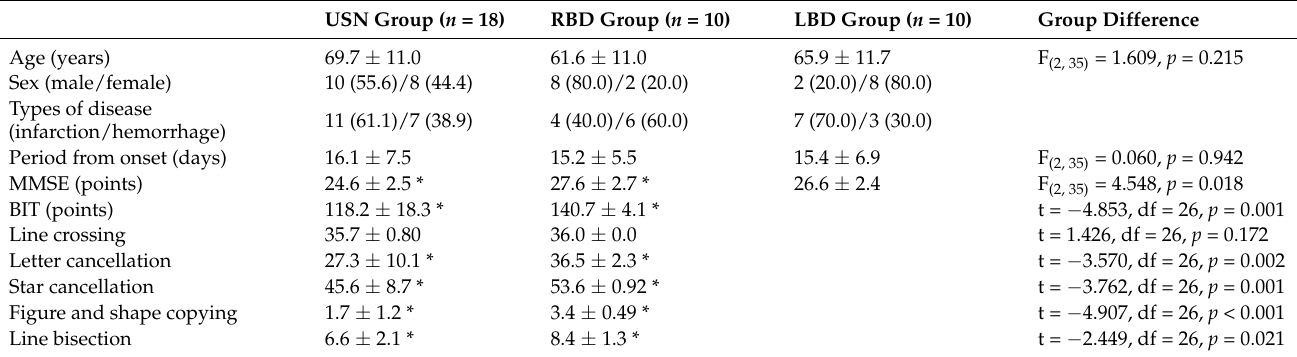
Table 1. Demographic and clinical data of all